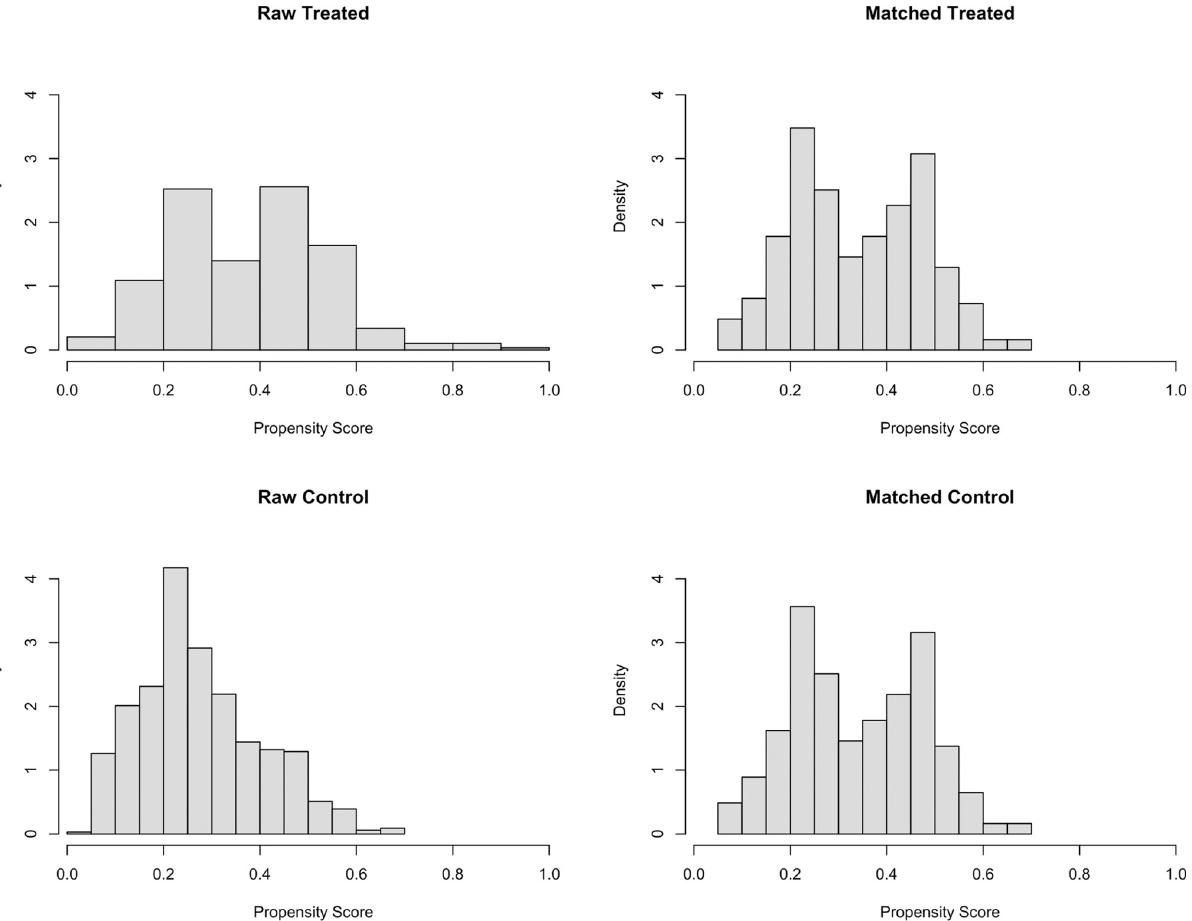
Fig 2. The histograms show the distribution of propensity scores before and after matching for the treated (disclosed HIV status) and untreated (undisclosed HIV status) groups. Raw treated: unmatched disclosed HIV status group; Raw control: Unmatched undisclosed HIV status group; Matched treated: matched disclosed HIV status group; Matched control: matched undisclosed HIV status